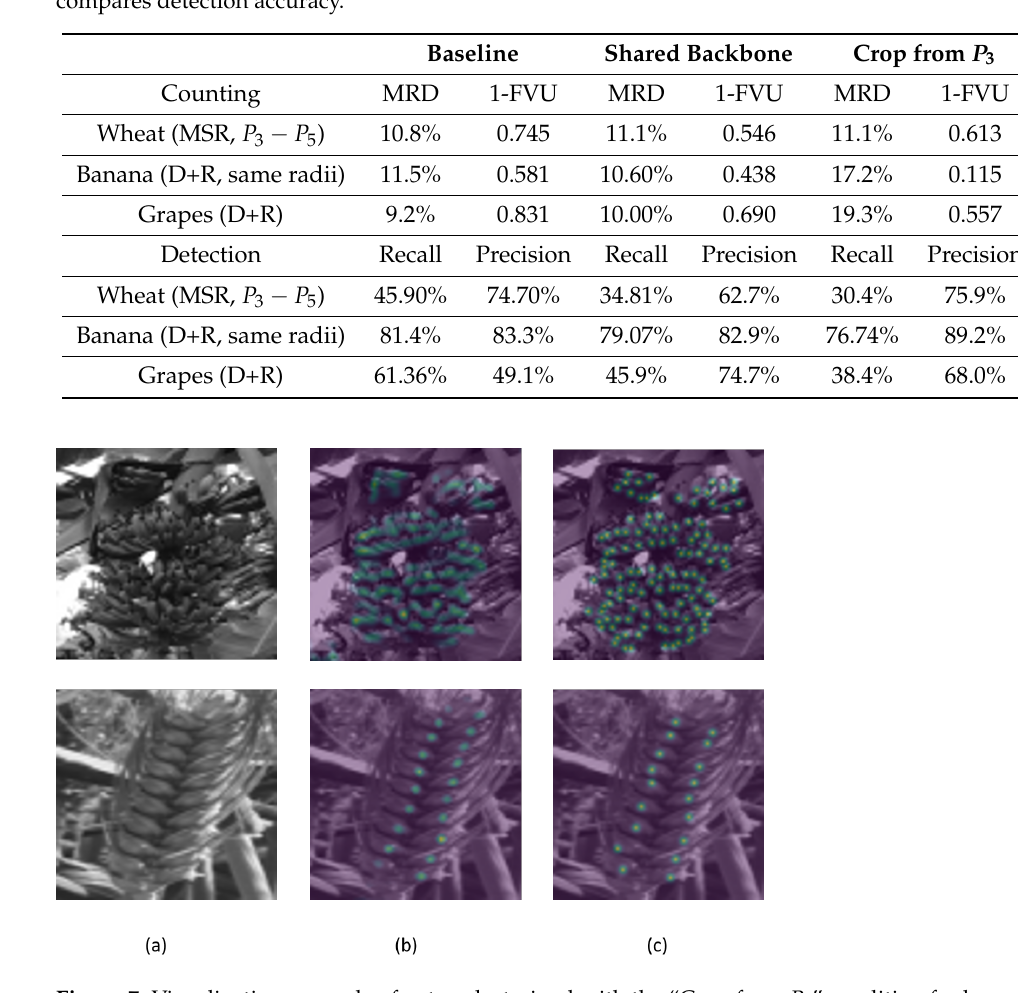
Figure 7. Visualization example of networks trained with the “Crop from P 3 ” condition for banana and wheat. Top Row: A Banana bunch, Bottom Row: A wheat spike. ( a ). Objects’ resized crop, ( b ). The heat map predicted by the network, ( c ). The ground truth heat